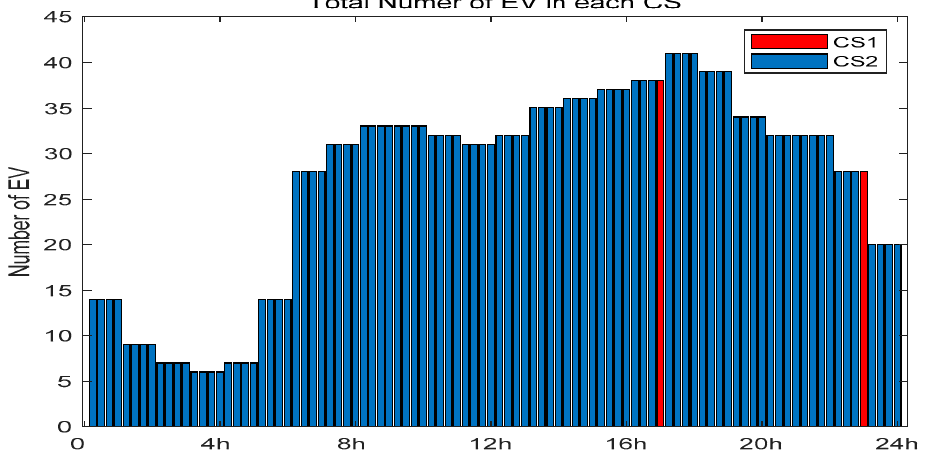
Figure 7. EV’s CS selection rate in Case 1.